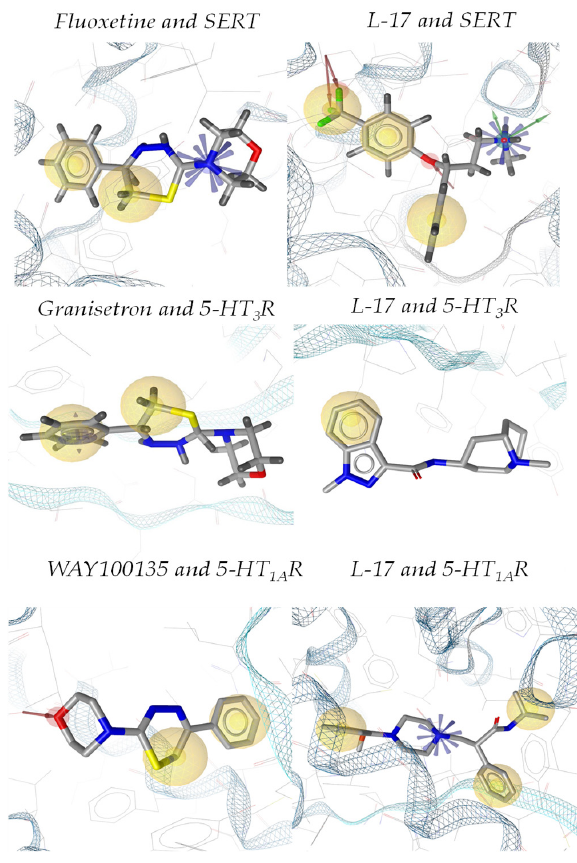
Figure 3. Poses of L-17, fluoxetine, granisetron, and WAY100135 within the binding sites of SERT, and 5-HT 3 and 5-HT 1A receptors. The pose of L-17 within the SERT binding site is remarkably close